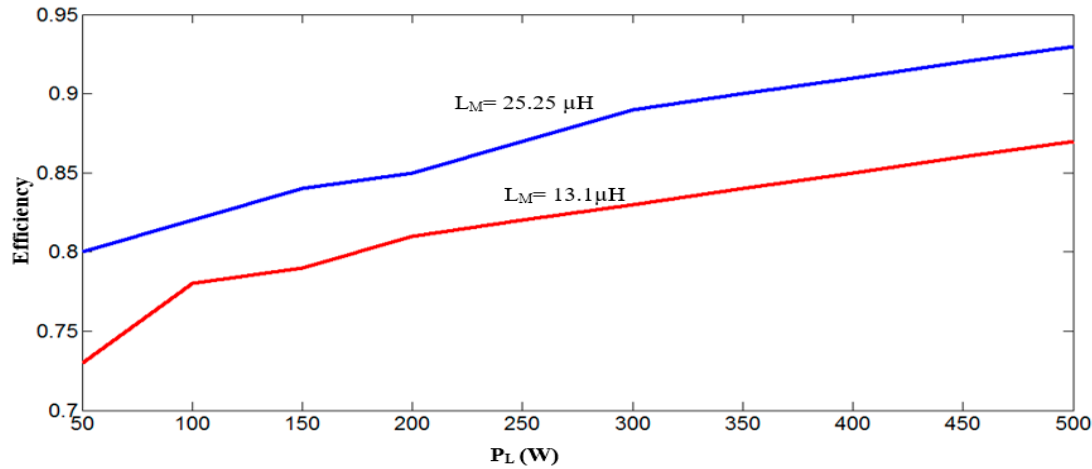
Figure 8. The efficiency of the 500 W LC-LC2 compensated resonant converter.